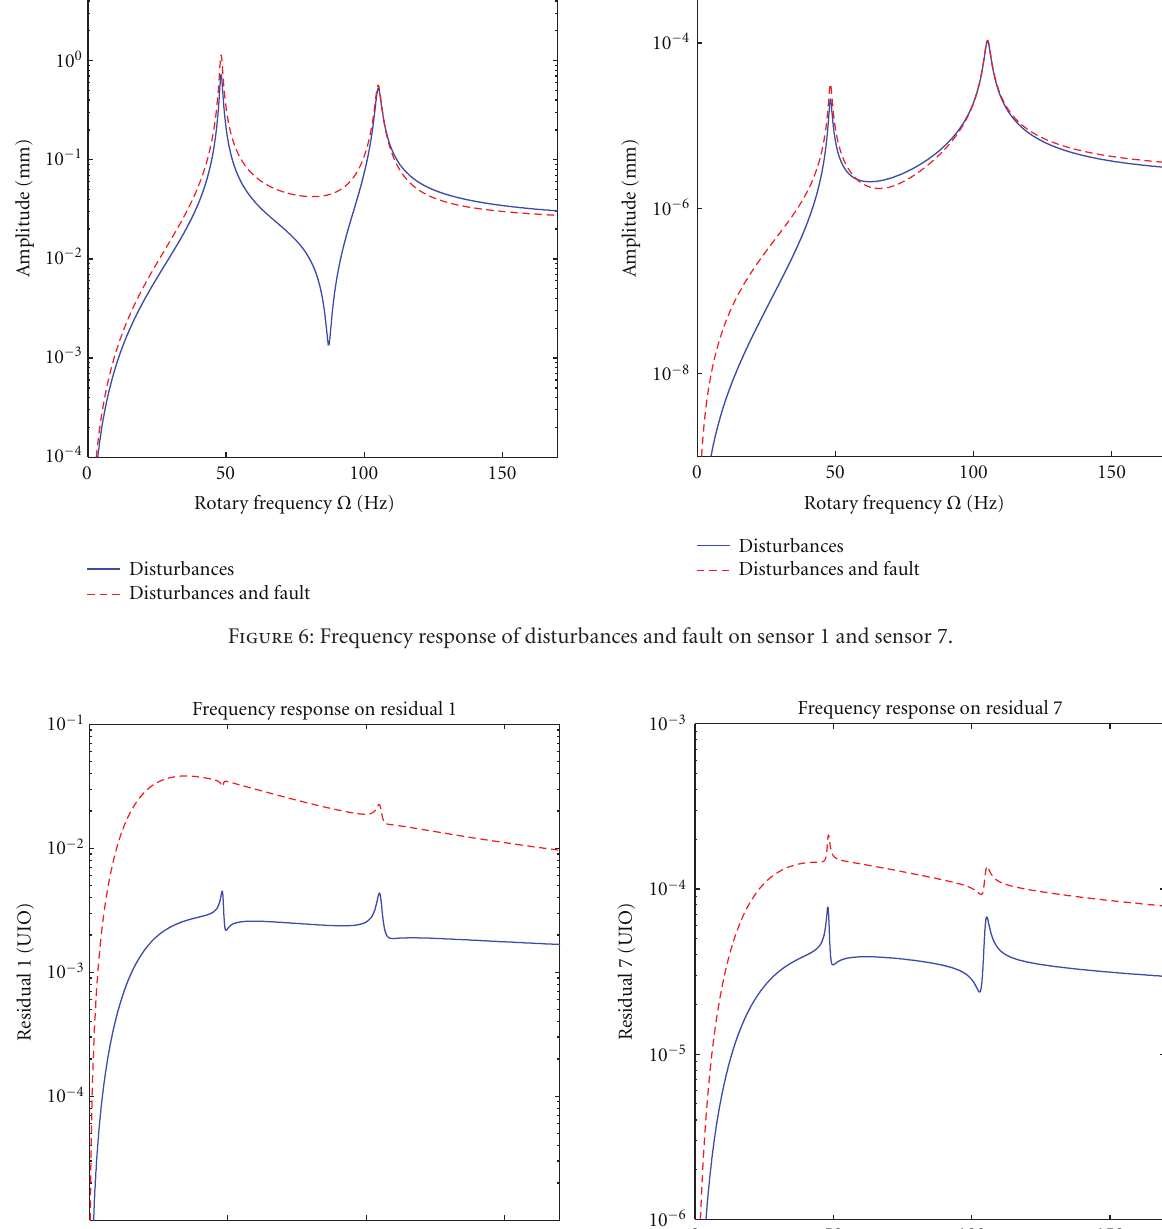
select δ = 15 and prevent overly large absolute values of the observer eigenvalues by r = 10 5 . Both values ( δ and r ) have been found to give good detection performance in the simulations and tests with measurement